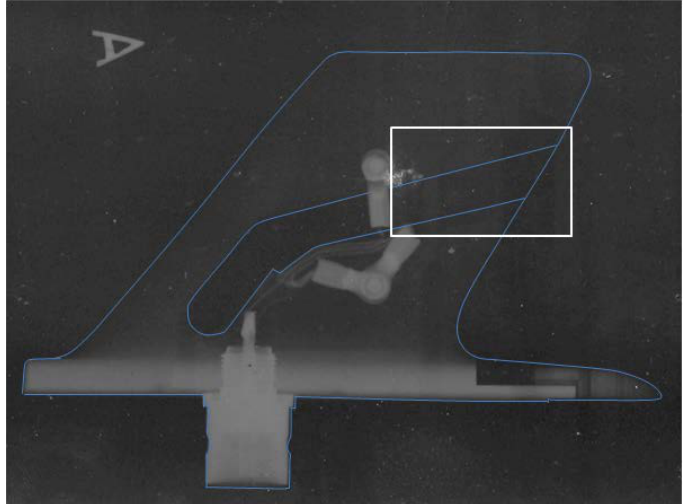
Figure 5: X-ray radiograph of the damaged antenna. Cracking area is indicated by white rectangular